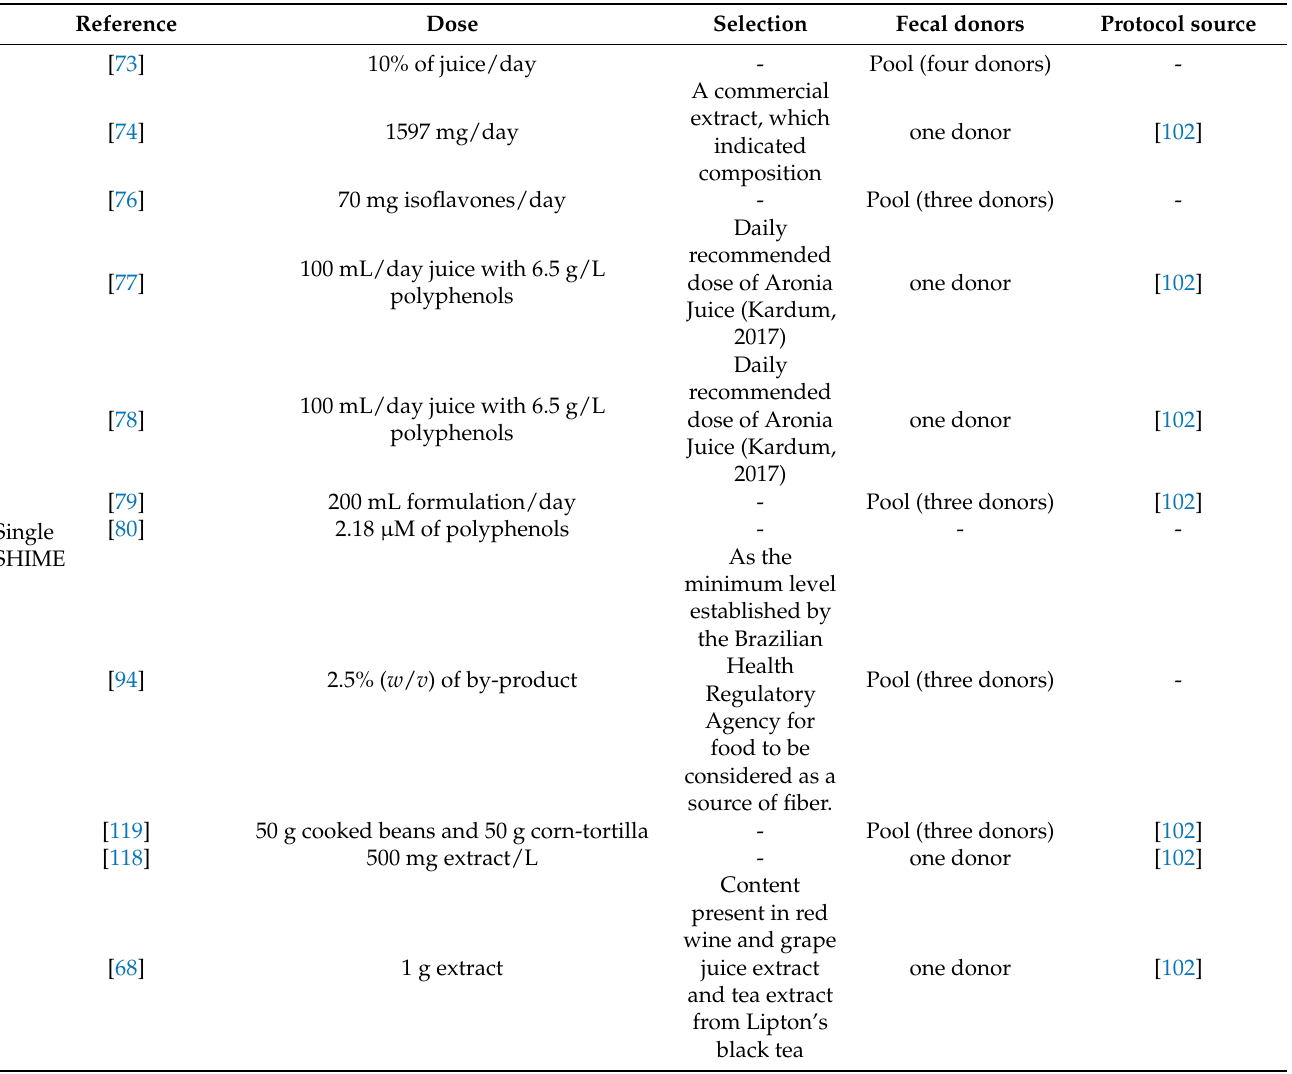
Table 4. Doses, selection, fecal donors and references for reviewed